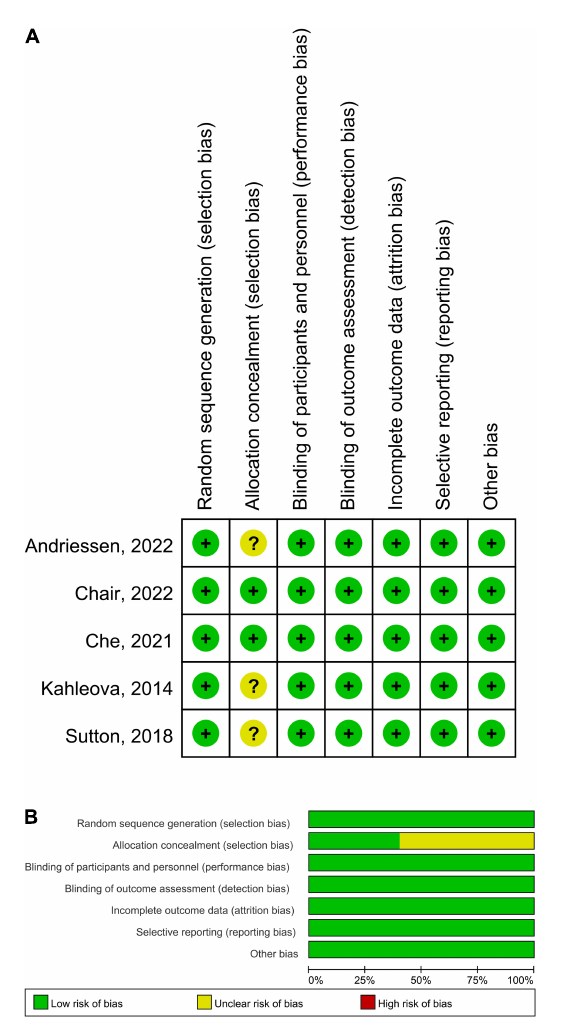
FIGURE2 Risk of bias of RCTs by the Cochrane risk assessment tool. (A) Risk of bias graph. (B) Risk of bias summary.